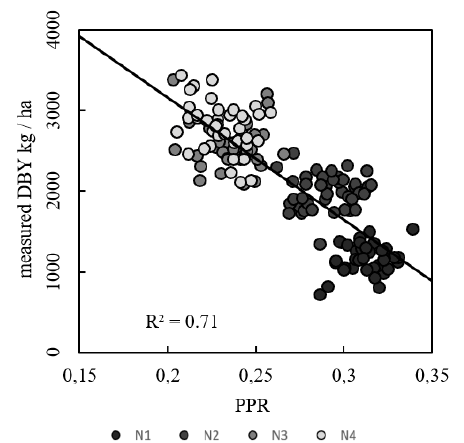
Figure 6. RGB-based Plant Pigment Ratio ( PPR ) vs. dry biomass yield (DBY).